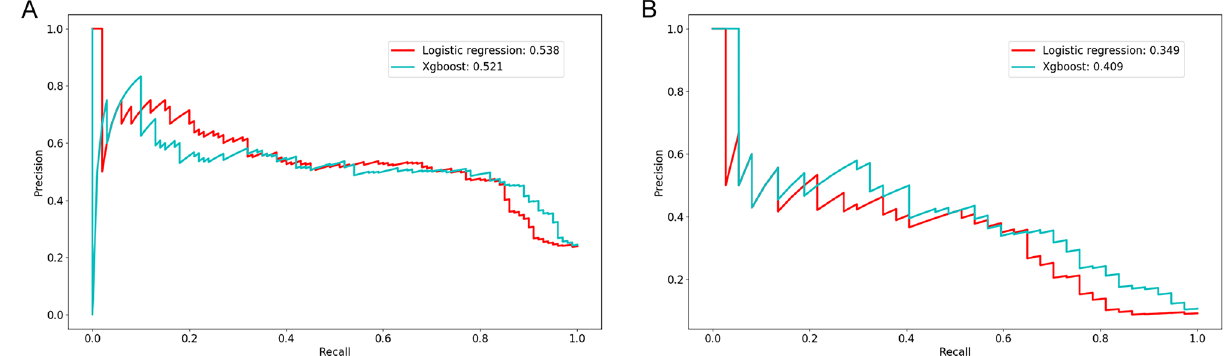
Figure 3. Precision-recall curves of the logistic regression and XGBoost models for MAKE30 ( A ) and 90-day adverse outcomes ( B ) in the test set. The figure was created using Python 3.6 (https:// www. python. org/).